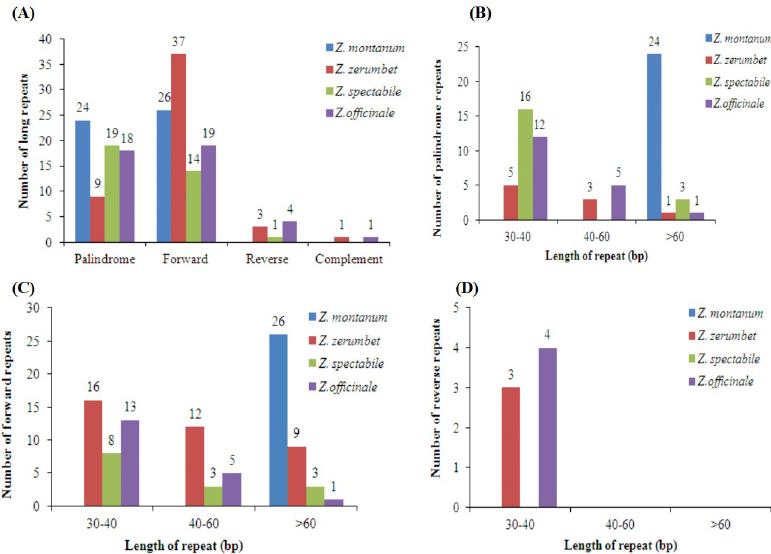
Fig 6. Analysis of long repeat sequences in the chloroplast genomes of the four Zingiber species. (A) Total of four long repeat types; (B) frequency of palindromic repeats by length; (C) frequency of forward repeats by length; and (D) frequency of reverse repeats by